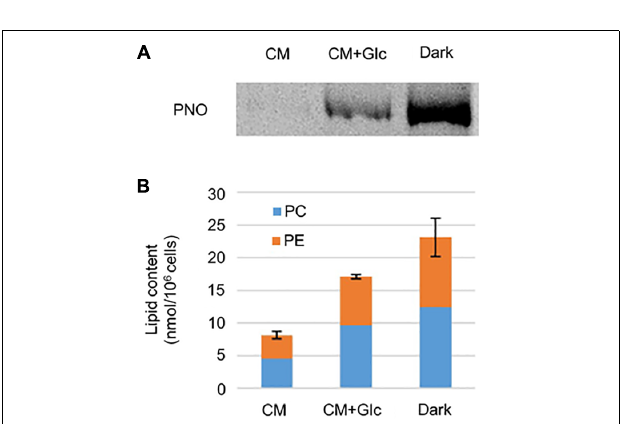
FIGURE 2 | Photosynthetic protein and thylakoid glycolipid levels in cells grown under photoautotrophic, photomixotrophic and heterotrophic conditions. (A) Western blot analysis of photosynthetic proteins. Antibodies used are indicated on the left. (B) Thylakoid glycolipid content. Error bar shows SE ( n = 3) of the total amount of glycolipids.